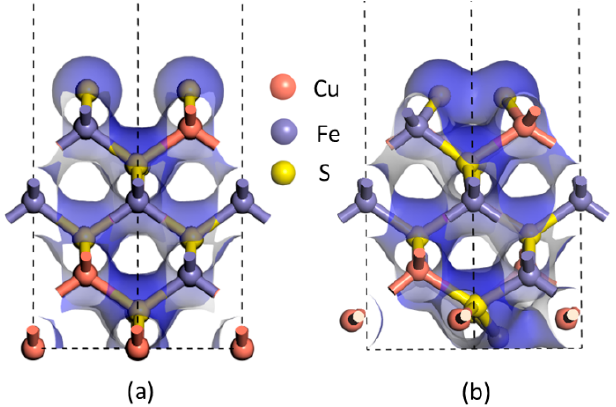
Figure 3. The electron density of chalcopyrite (001)-S surfaces: ( a ) unrelaxed and ( b ) relaxed.